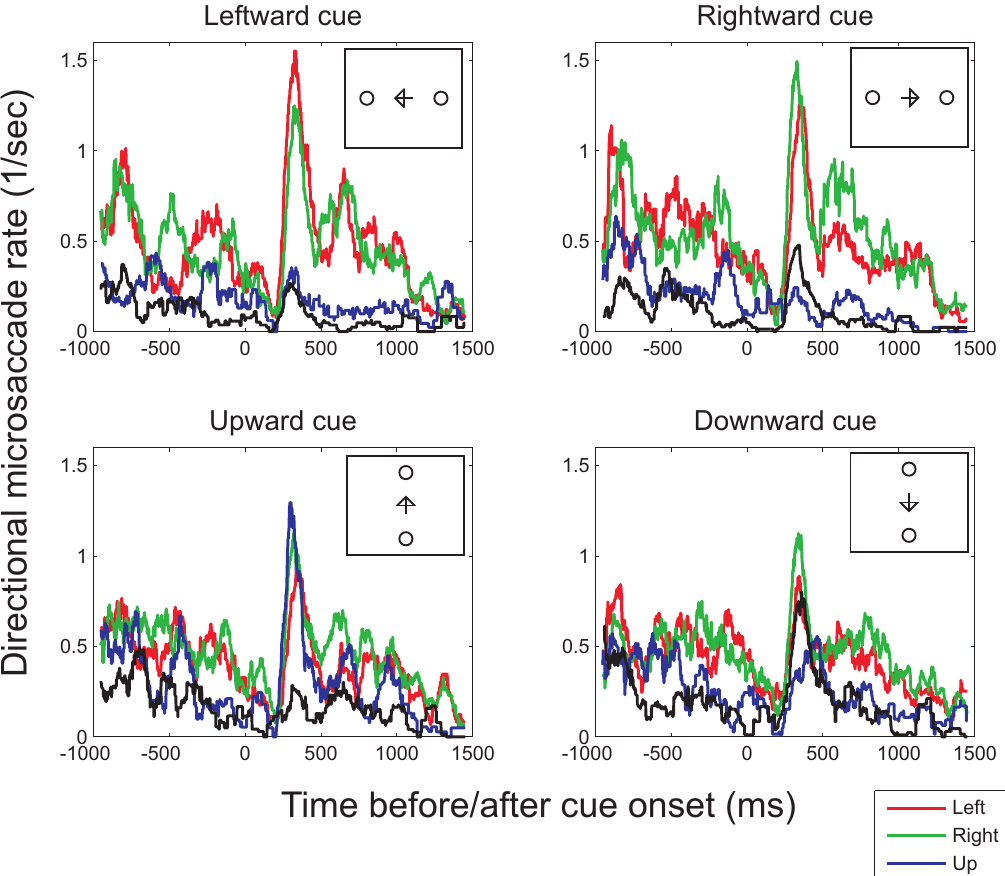
Figure 6 . Binocular microsaccade rates in each of the four principal directions (left, right, top, bottom) as a function of the time before (negative values on the horizontal axis) or after cue onset (positive values) for the conditions in which either positions left or right from fixation were cued (top row) or in which the top or bottom positions were cued (bottom row; illustrated in the small insets). To compute the histograms, a moving-window analysis with a window of 100ms and time-steps of 1ms was